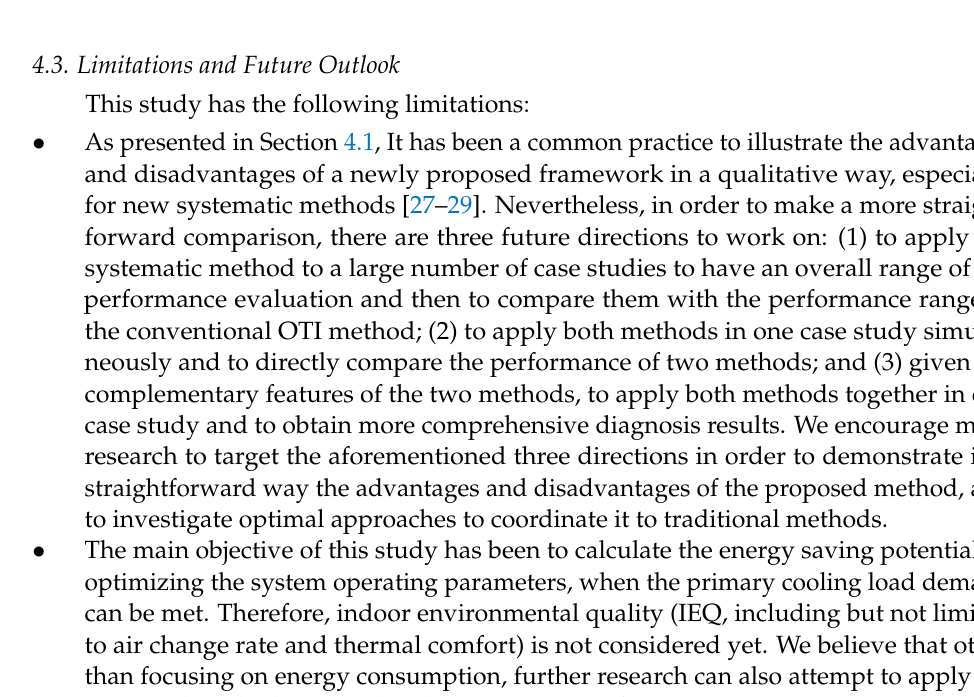
Figure 4. Influence of data completeness on the mining method and achievable objectives.